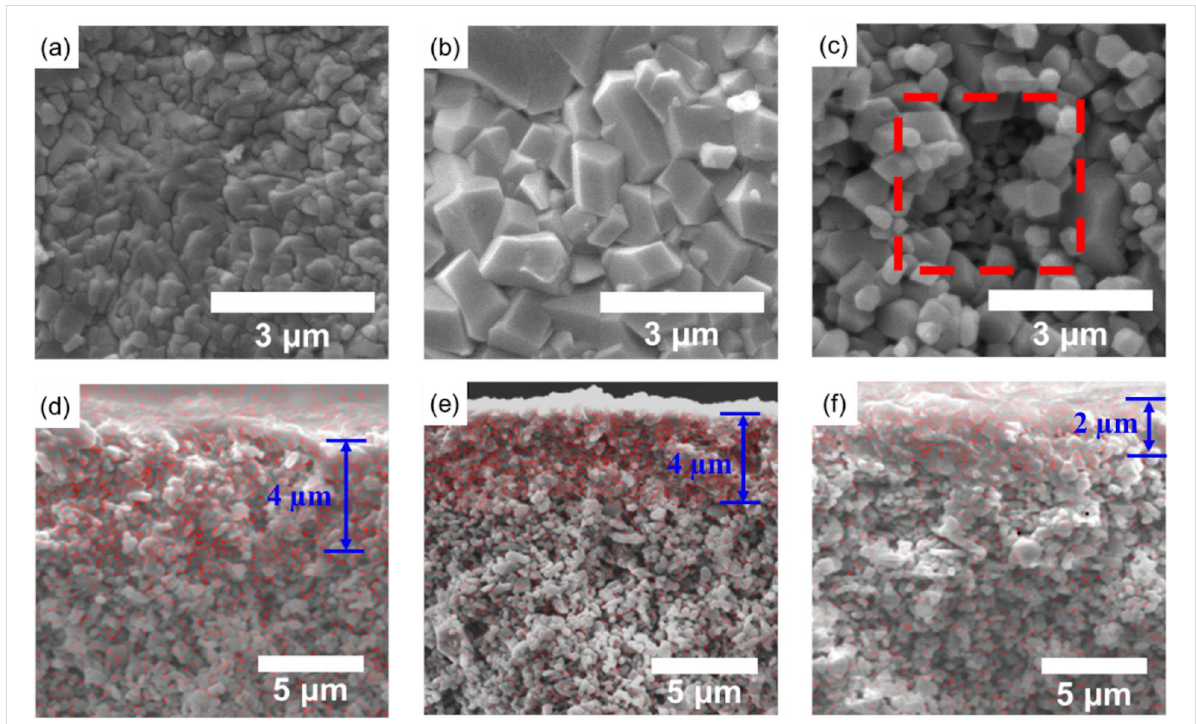
Figure 3: Top-view SEM images of ZIF-8 membranes fabricated at (a) 40 °C, (b) 80 °C, and (c) 120 °C, after 12 h. Cross-sectional EDS mappings of ZIF-8 membranes fabricated at (d) 40 °C, (e) 80 °C, and (f) 120 °C, after 12 h (red represents Zn).